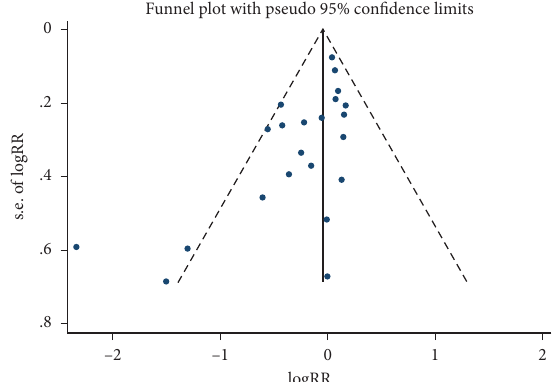
Figure 4: Te funnel plot for publication bias, comparing the overall mortality in the vitamin C and control groups. A blue dot represents a single study, and the funnel dotted line represents 95% confdence intervals. Table 2: Meta-regression analysis summary according to the protocol, quality of the studies, blinding method, and publication year. Coef. Std. err. z P > | z |